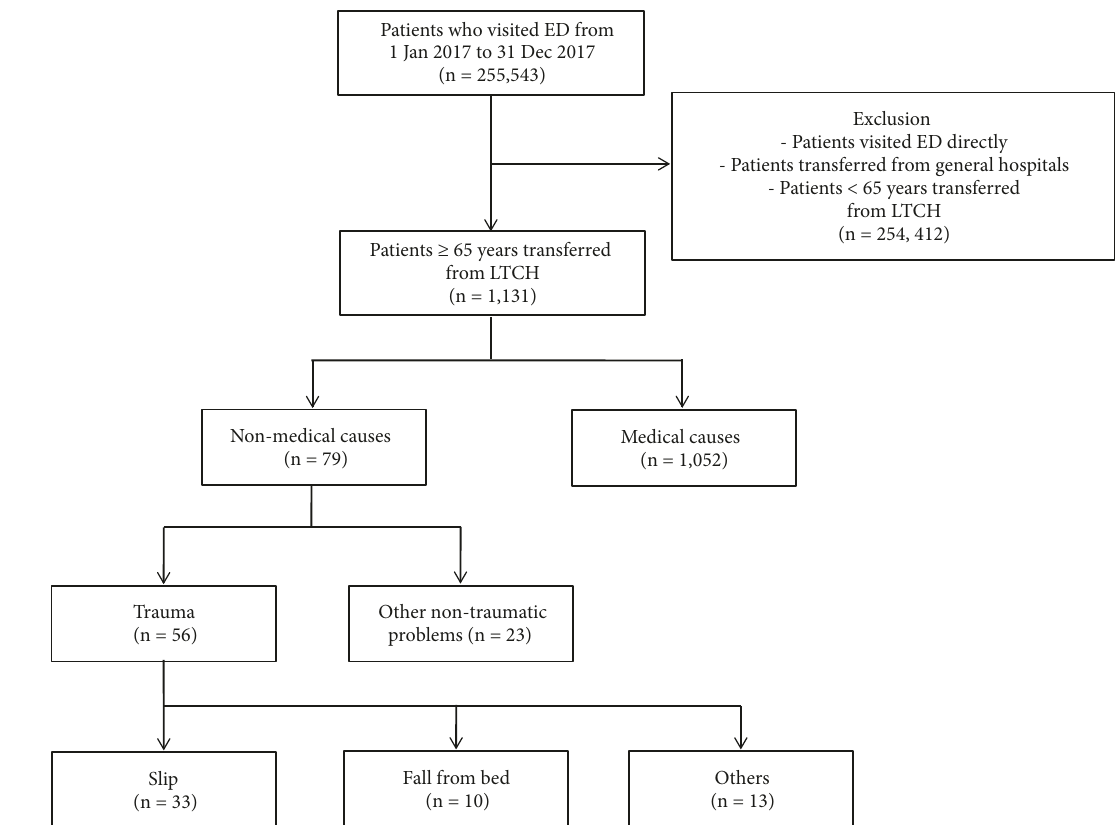
Figure 1: The flow chart of enrolled